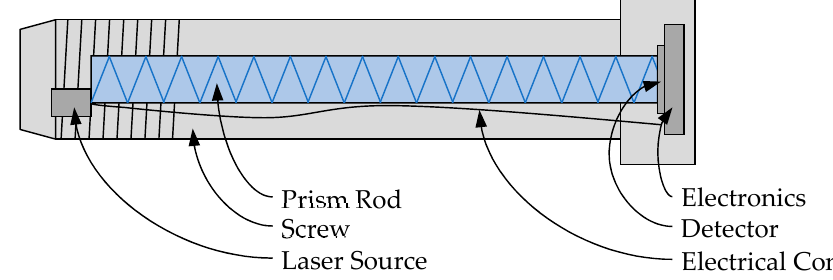
Figure 5. Concept of the sensor system integrated in a screw.